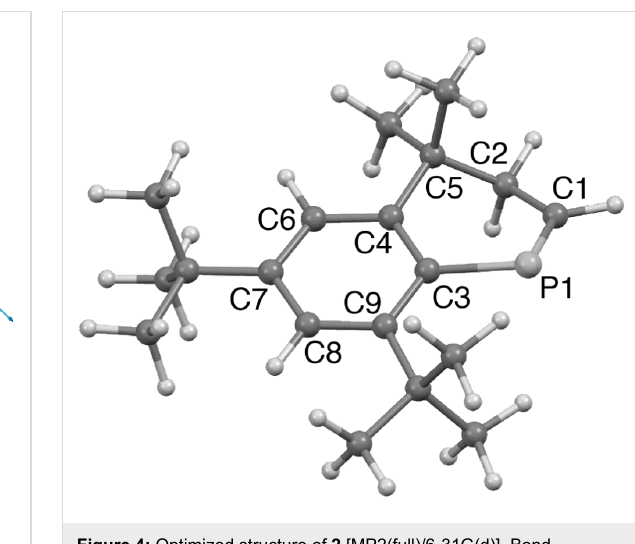
Figure 4: Optimized structure of 2 [MP2(full)/6-31G(d)]. Bond distances (Å): P1–C1 1.678, C1–C2 1.491, P1–C3 1.840,